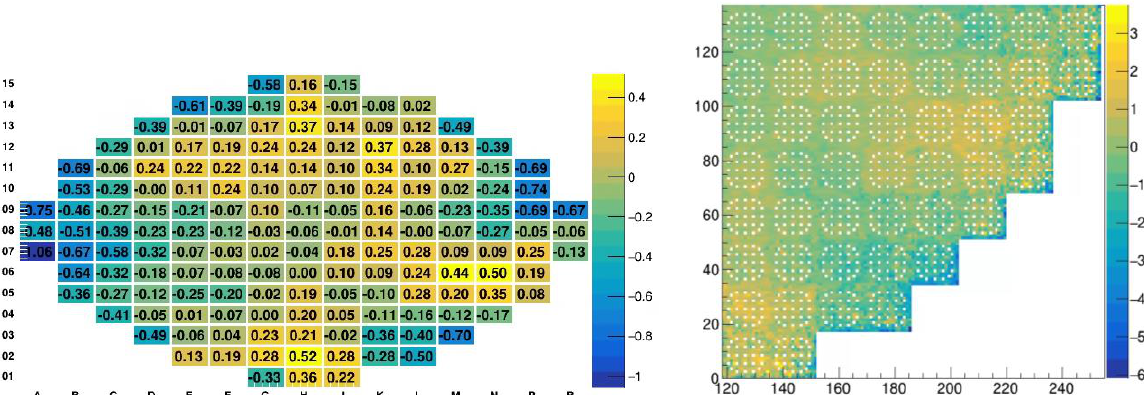
Figure 4. Fission rate distribution comparison (MCNP-CASMO/CASMO) on the assembly level and pin